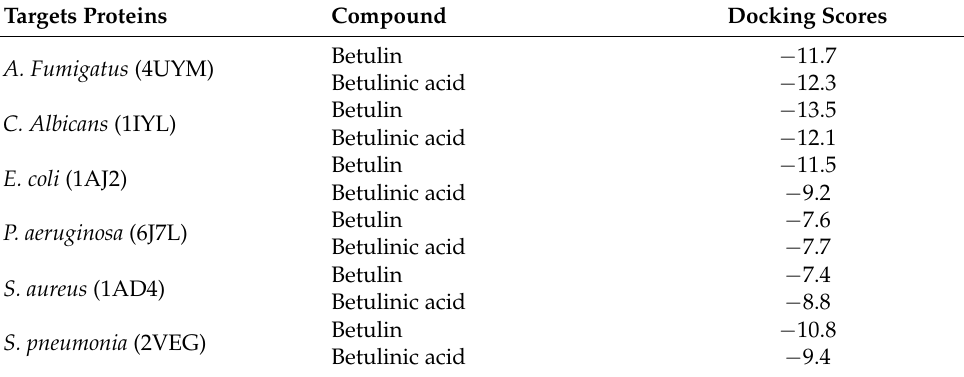
Figure 4. Interaction of 4UYM, 1IYL, 1AJ2, 6J7L, 1AD4, and 2VEG proteins with ligand betulinic acid. Table 4. The predicted docking scores of betulin and betulinic acid for inhibitor binding with tested proteins.